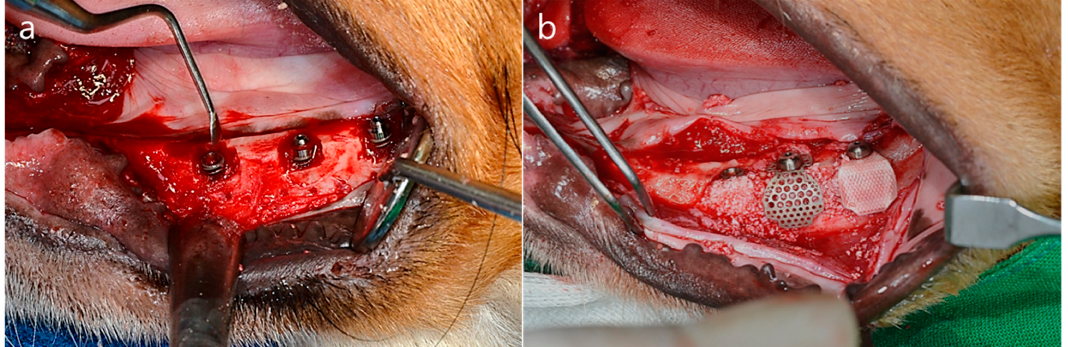
Figure 3. Operation procedures ( a ) The alveolar ridge was adjusted by approximately 1.5 mm to form a flat ridge. Buccal open defects of 2.5 mm in depth were created. Implants were placed into the edentulous mandibular alveolar ridge; ( b ) Bone grafting material was used to fill the defects. The membrane was added to cover the buccal open defects.